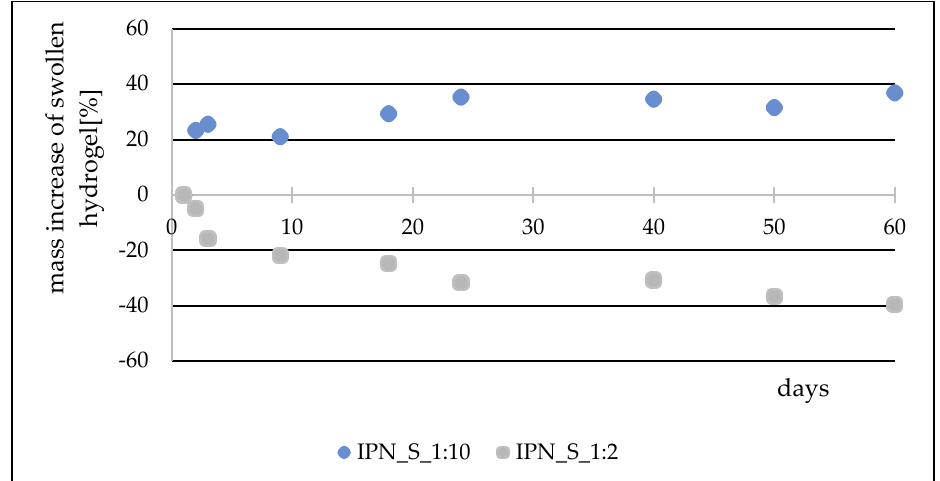
Figure 7. Mass changes over a two-month period for chosen IPNs.